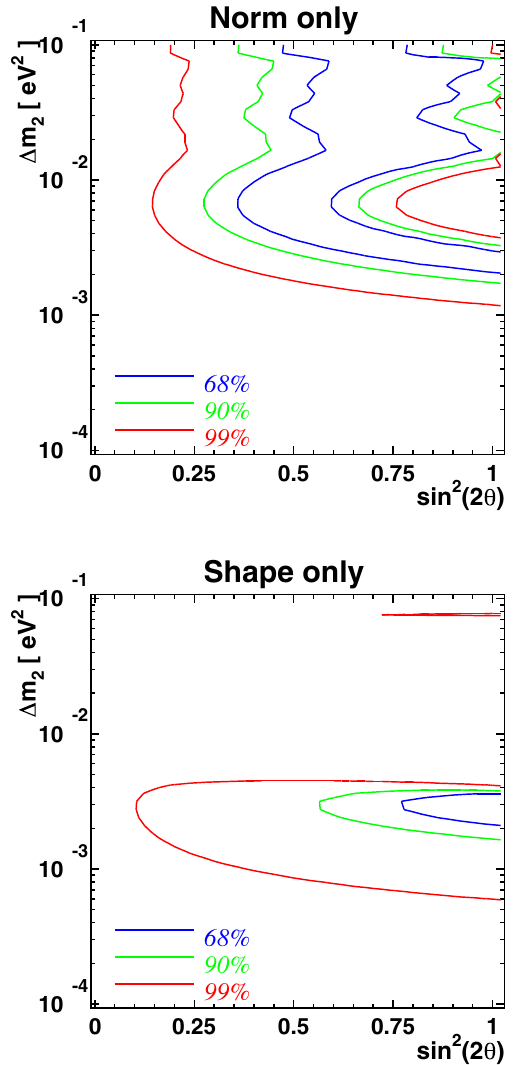
Fig. 35 Allowed region of oscillation parameters evaluated with the normalization-only (top) and the E rec ν shape-only (bottom). Both infor- mation allow the consistent region on the parameters